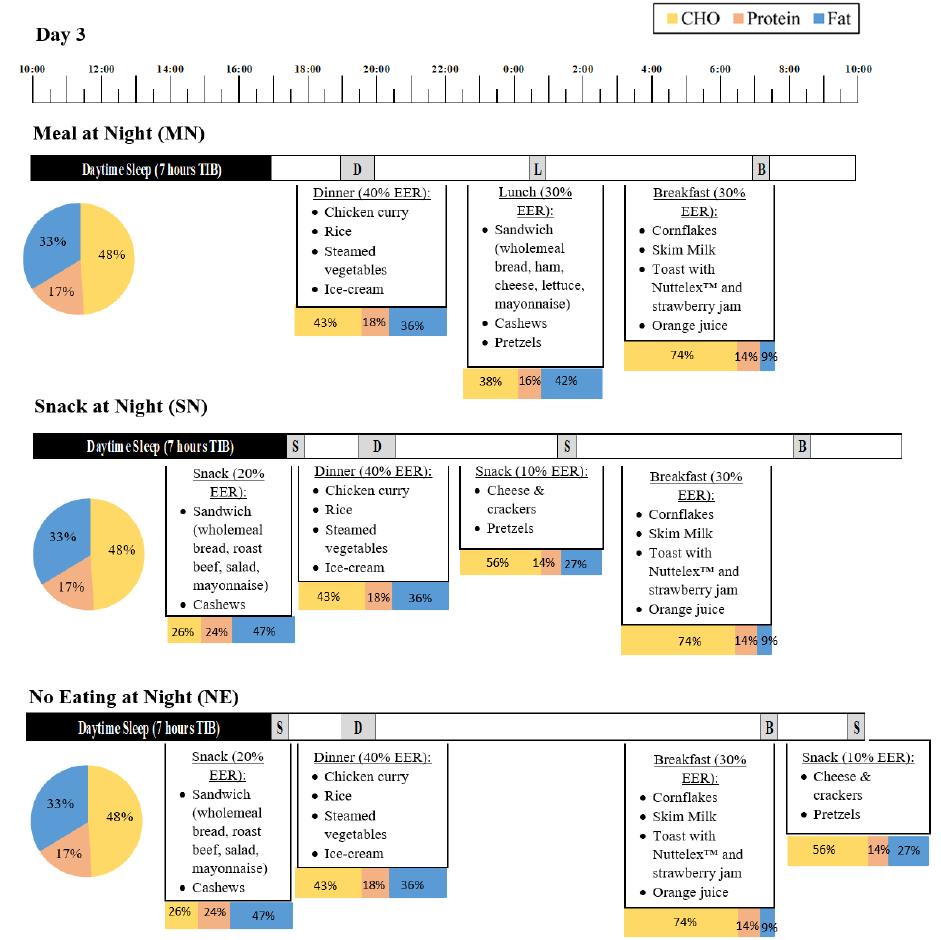
Figure 2. Example meal plan for day 3 of the simulated shiftwork protocol for a participant with an EER of 9500 kJ. The upper panel shows the Meal at Night condition (MN), the middle panel shows the Snack at night condition (SN) and the lower panel shows the No Eating at Night condition (NE). The pie chart represents the proportion of carbohydrates (CHO; yellow), protein (orange), and fat (blue) for the total 24 h period of NS3, and the stacked bars indicate the proportion of carbohydrate, protein, and fat for each meal and snack within the 24 h period of nightshift 3. Values may not total 100% due to small contributions from fibre. There were some variations between conditions in the foods provided, however 24 h macronutrient intake was matched.